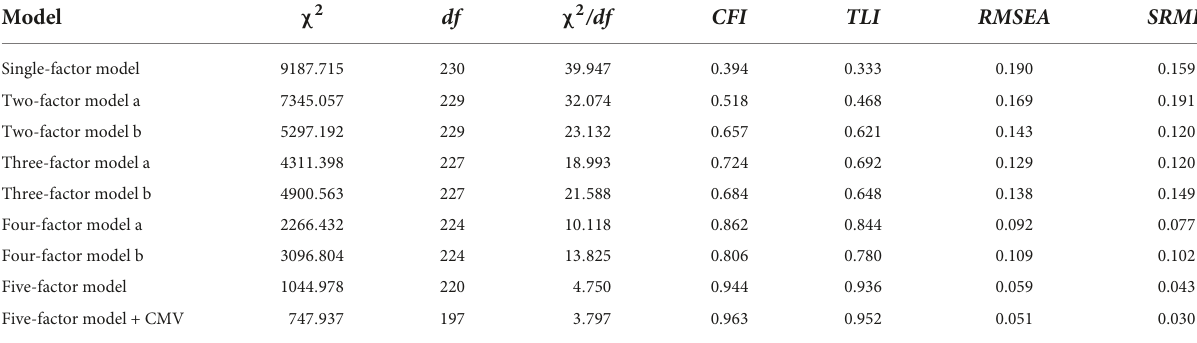
TABLE 2 Discriminant validity and common method bias test results.